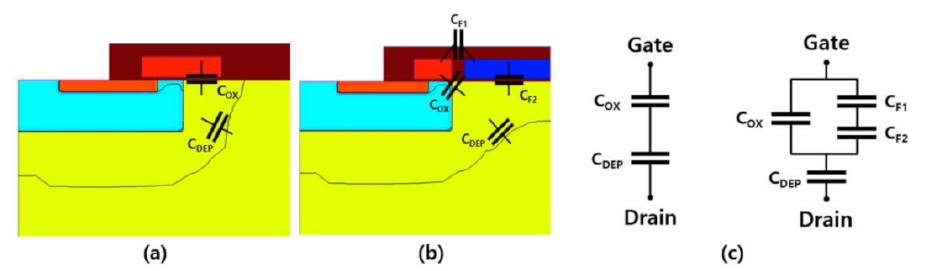
Figure 5. Depletion lines and C GD (gate-to-drain capacitance) factors distribution of ( a ) SG- DMOSFET (split-gate DMSOFET); ( b ) FPS-DMOSFET (floating p+ polysilicon split-gate DMOSFET); and ( c ) models schematically showing the capacitance of the two